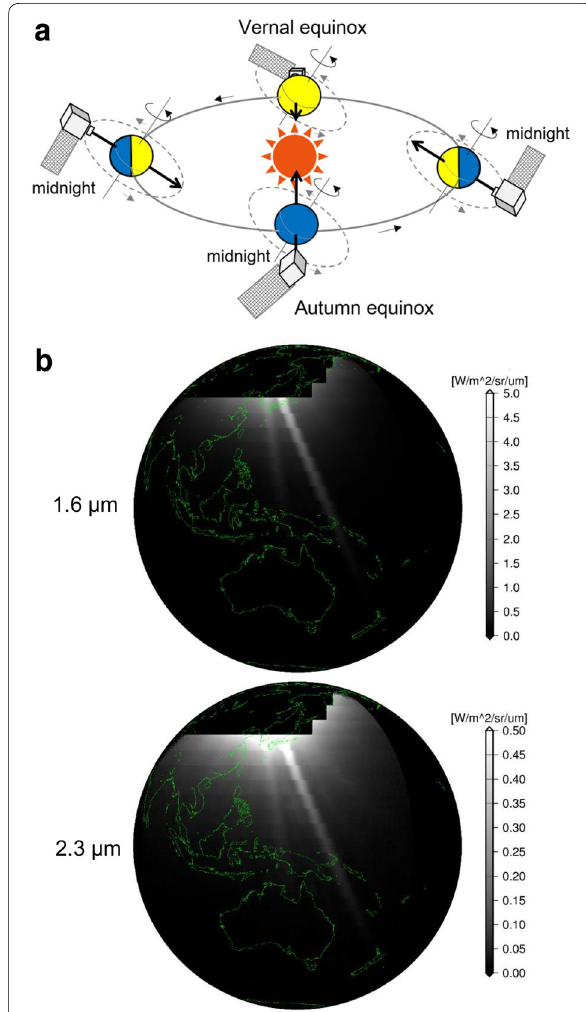
Fig. 3 a Schematic of relationship between orbital motions of Himawari-8 and the earth resulting in periodic earth eclipses. When Himawari-8 is located at the points where its orbital plane intersects that of the earth, all three bodies—Himawari-8, the earth, and the sun—are in the same plane. During the vernal and autumn eclipse periods, these conditions make the Himawari-8 imager face the sun, which causes an earth eclipse. b Stray light in the AHI images for 1.6-µm (upper) and 2.3-µm (lower) bands at 14:40 UTC on April 12, 2018. The scale represents radiance (W m − 2 sr − 1 µm − 1